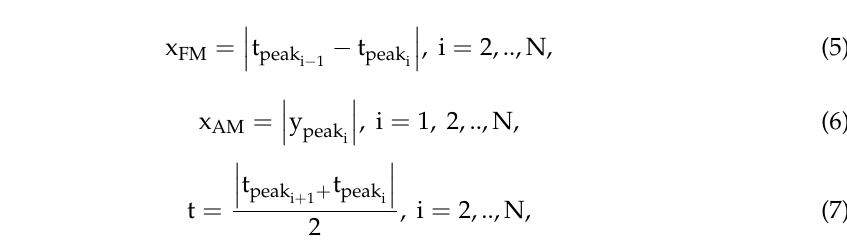
Table 3. Parameters of payload.